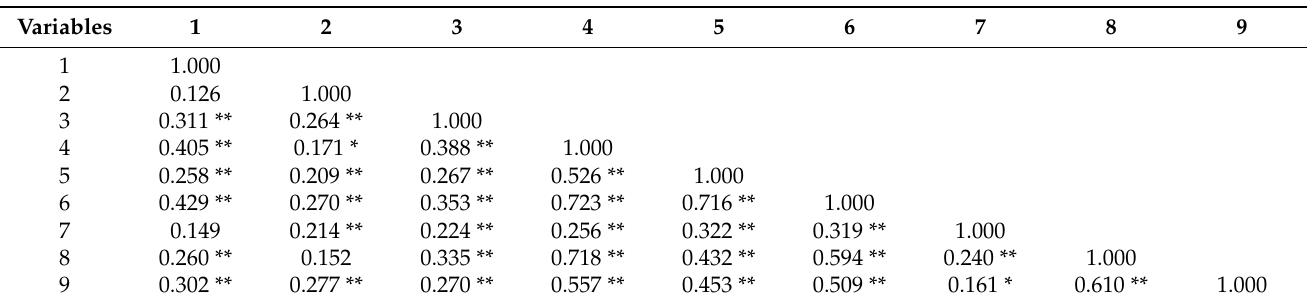
Table 6. Correlation between experience related to the elderly and subfactors of the perception of human rights violations against the elderly.